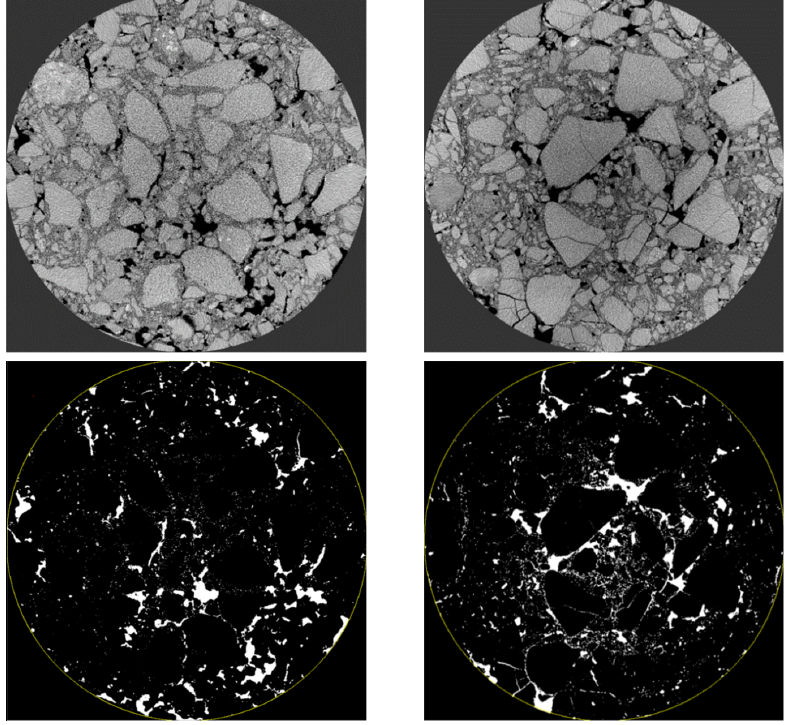
Figure 19. The distribution of void and crack before and after spli tt ing of lower specimen.